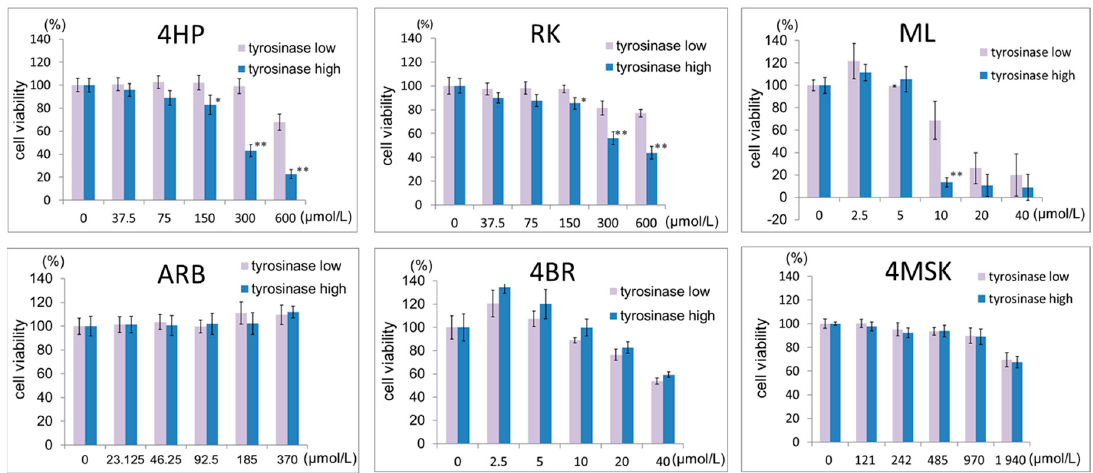
Figure 1. Effects of 4HP, RK, ML, ARB, 4BR, and 4MSK on the number of viable cultured B16 melanoma cells (3 days after addition). Viable cell numbers are shown, with the control set as 100%. Results are presented as the mean ± S.D. of three experiments. * p < 0.05, tyrosinase low vs. tyrosinase high at the same concentration; ** p < 0.01, tyrosinase low vs. tyrosinase high at the same concentration. 4HP, rhododendrol; RK, raspberry ketone; ML, magnolignan; ARB, arbutin; 4BR, 4-n-butylresorcinol; 4MSK, 4-methoxysalicylic acid potassium salt.